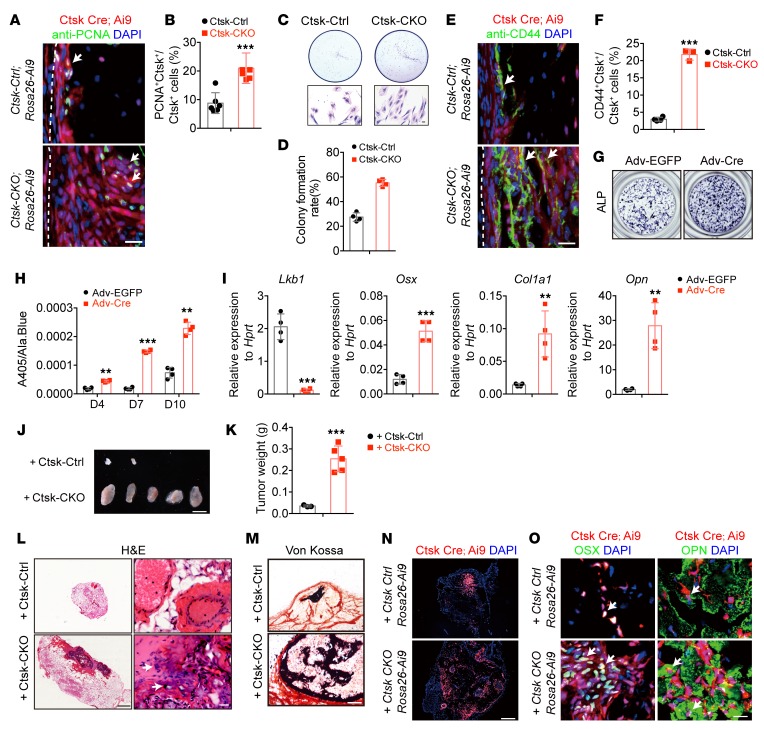
LKB1-deficient Ctsk+ cells display higher self-renewal and osteoblast differentiation ability.(A and B) Immunostaining of PCNA in Ctsk-Cre–expressing cells in Ctsk-CKO mice showed increased proliferation rate. Scale bar: 50 μm. (C and D) Plate colony formation of Ctsk-Ai9 cells purified via flow cytometry from the cortical bone of Ctsk-Ctrl; Rosa26-Ai9 and Ctsk-CKO; Rosa26-Ai9 mice, showing an enhanced proliferation rate of cells from Ctsk-CKO; Rosa-Ai9 mice. Scale bar: 10 μm. (E and F) Confocal images showing that expanded Ctsk-Cre–positive cells (red) in the cortical bone of Ctsk-CKO; Rosa26-Ai9 tibiae displayed a higher frequency of CD44-positive cells (white arrows). Scale bar: 20 μm. (G–I) Deletion of Lkb1 in the periosteal cortical bone cells via Cre adenovirus (Adv-Cre) leads to increased osteoblast differentiation monitored by ALP staining. (G) Supernatant ALP activity relative to the cell number measured via Alamar blue (Ala.Blue) (H) and marker gene expression (I) after 7-day induction. (J–O) Transplantation of periosteum-derived cells from 4-week-old Ctsk-Ctrl; Rosa-Ai9 and Ctsk-CKO; Rosa-Ai9 mice to the nude mice subcutaneously. (K) Weight of bone organoids formed by Ctsk-Ctrl; Rosa-Ai9 (3/5) and Ctsk-CKO; Rosa-Ai9 (5/5) cells. (L and M) Representative images of H&E staining (L) and von Kossa staining (M) of the bone organoids. Scale bars: 500 μm (left); 20 μm (right). (N) Confocal imaging showing Ctsk-Ai9+ cells were involved in osteoid formation. Scale bar: 200 μm. (O) Immunostaining of osteogenic marker, OSX (green), and OPN (green) showing osteogenic potential of transplanted Ctsk-Ai9 cells (white arrows). Scale bar: 20 μm. Data are represented as mean ± SEM. **P < 0.01; ***P < 0.001, unpaired Student’s t test.